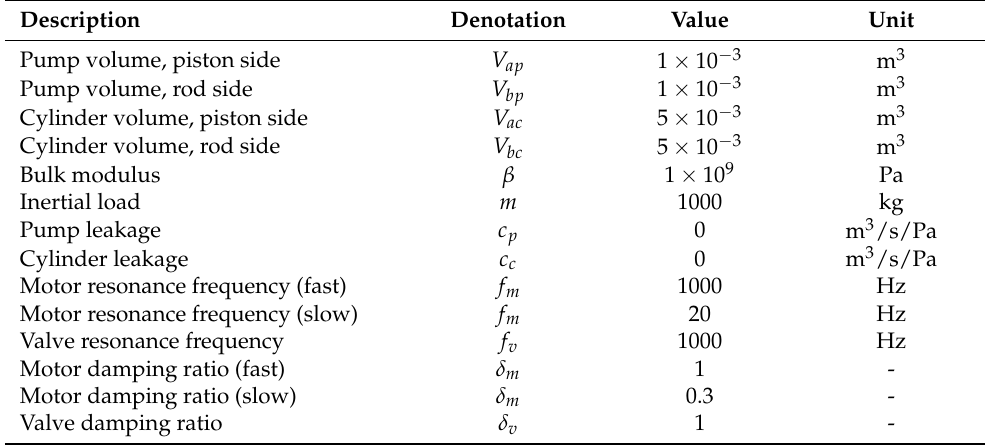
Figure 12. Step response from external force to sensed pressure difference. Table 3. Complementary parameter values for dynamic modelling. Parameters for motor dynamics are provided for two cases: slow and fast. If nothing else is stated, fast parameters are